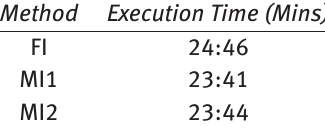
Table 4: Average Execution Times by